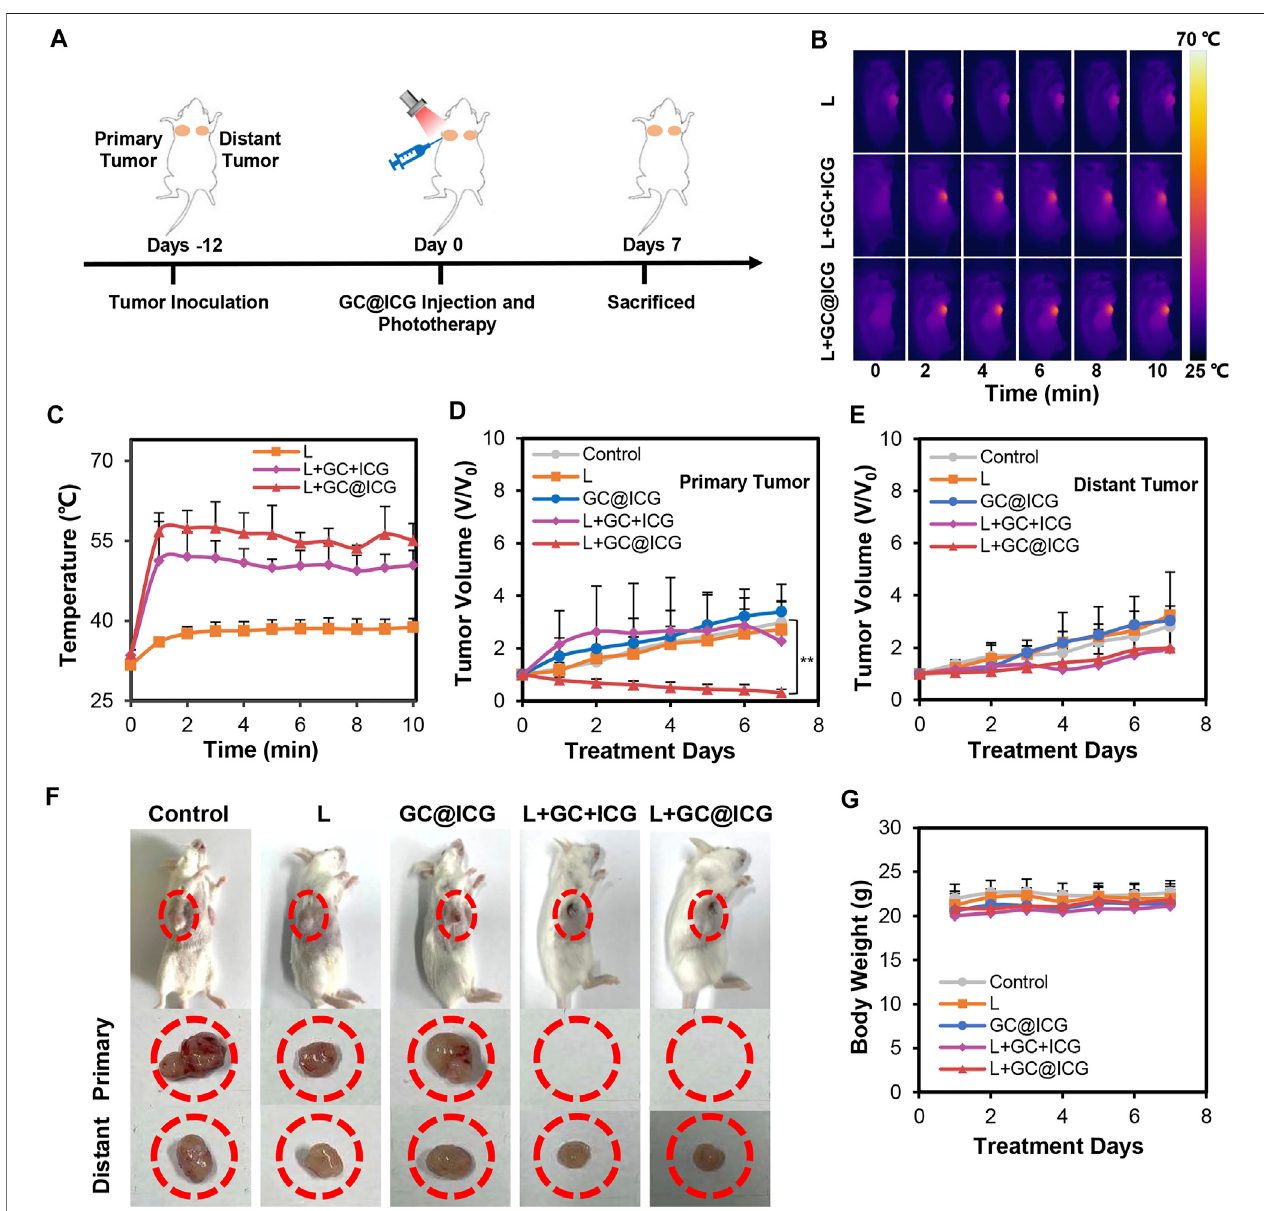
FIGURE 4 | In vivo antitumor effect of GC@ICG-based phototherapy. (A) Schematic illustration of the timeline of the animal experiment for GC@ICG-based phototherapy. (B) Near-infrared thermal images of mice during 808 nm laser irradiation at 0.8 W/cm 2 for 10 min. (C) Temperature elevations on primary tumor surface during laser irradiation based on infrared thermal imaging. Time-dependent tumor growth curves of primary (D) ( n = 3, pp p < 0.01) and distant tumors (E) . (F) Photographs of mice with different treatments (from left to right: control; L; GC@ICG; L + GC + ICG; L + GC@ICG). (G) The change of body weights of mice after different